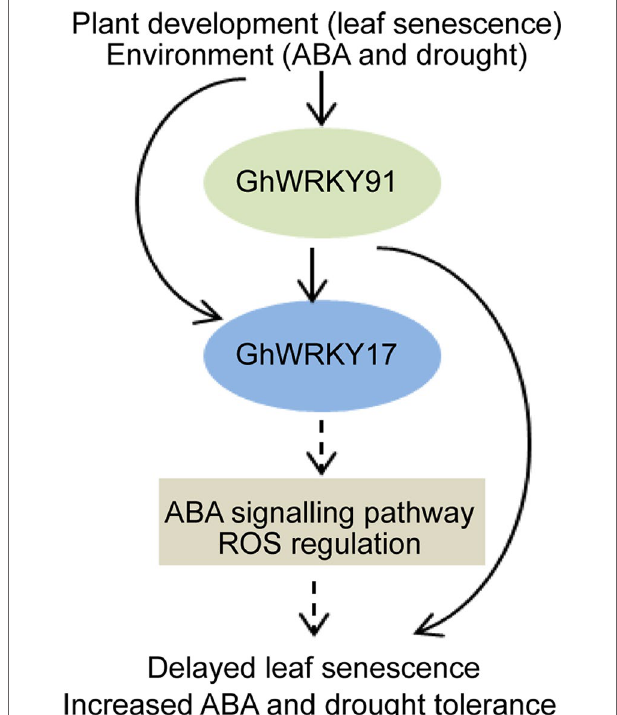
FIGURe 8 | Proposed model for the regulatory mechanism of GhWRKY91. The expression of GhWRKY91 and GhWRKY17 is influenced by leaf senescence, ABA, and drought stresses. GhWRKY91 actives the expression of GhWRKY17 , which is associated with ABA signalling pathways and ROS production. The solid arrows indicate results that have been experimentally determined, whereas dashed arrows indicate speculated effects supported by the